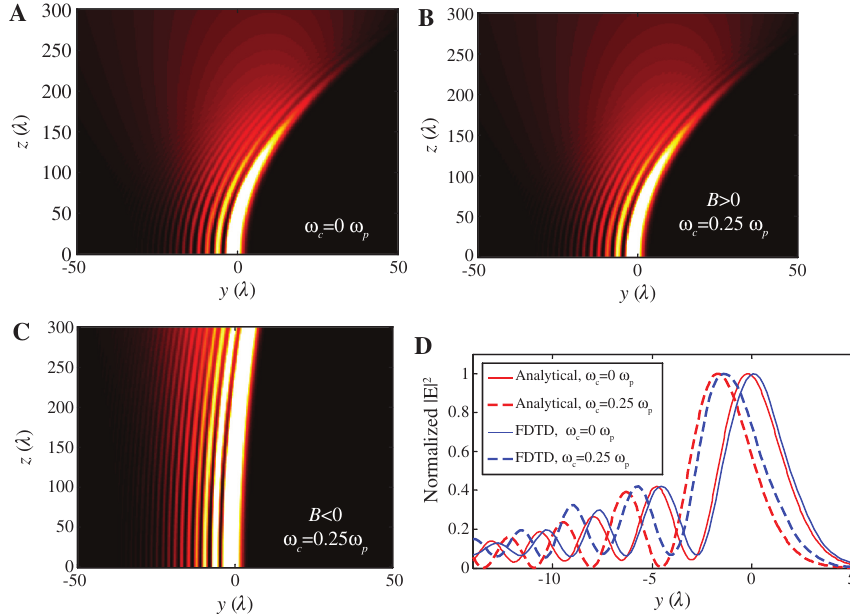
Figure 4: Magnetic field tuning of Airy SMPs (from [68]). Theoretical calculated electric fields of the Airy SMPs on the semiconductor surface with an incident frequency of ω = 0.85 ω when (A) No magnetic field is applied, (B) A magnetic field is applied with ω = 0.25 ω (C) A magnetic field is applied with ω . (D) Comparison of theory (red lines) and FDTD simulation (blue lines) results of normalized c p electric field distributions after Airy SMPs propagate 50 λ . Solid lines: field distributions when ω = 0.25 ω when ω for B < c p